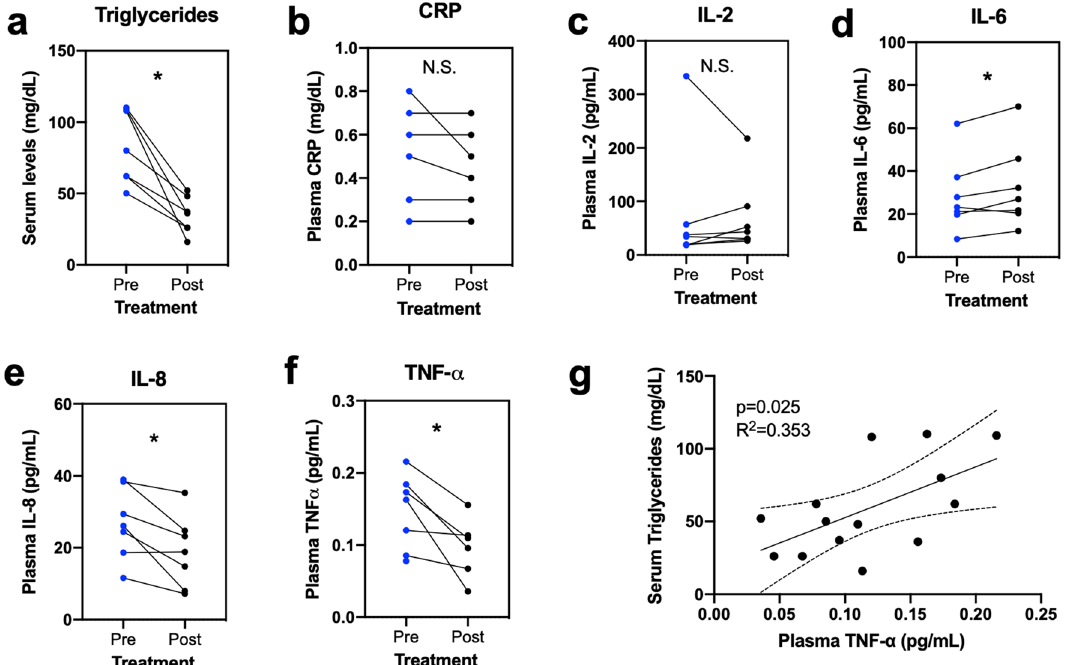
Figure 2. Fenofibrate significantly lowers serum triglyceride concentrations and plasma IL-8 and TNF-α concentrations. ( a ) Serum triglyceride concentrations in 7 diabetic dogs treated with fenofibrate for 3 weeks (Day 21) compared to concentrations at baseline (Day −14). Comparison of plasma ( b ) CRP and inflammatory cytokines ( c ) IL-2, ( d ) IL-6, ( e ) IL-8, and ( f ) TNF-α following fenofibrate administration. ( g ) Correlation of serum triglyceride concentrations and plasma TNF-α concentrations. * P < 0.05, ** P < 0.01 by Wilcoxon test. N.S., not